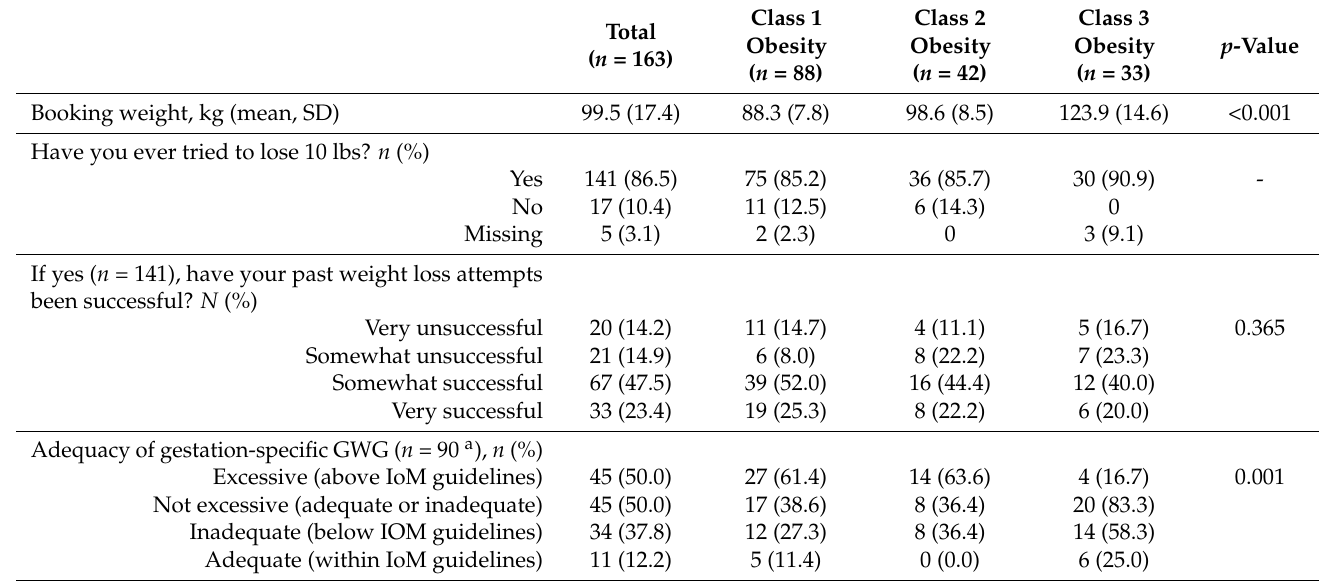
Table 5. Descriptive analysis of weight-related